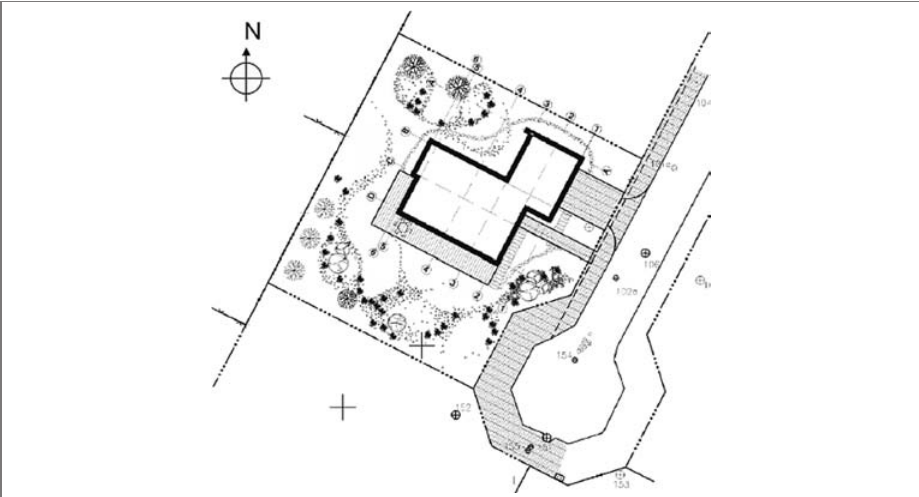
Fig. 1. Passive house orientation according to cardinal points